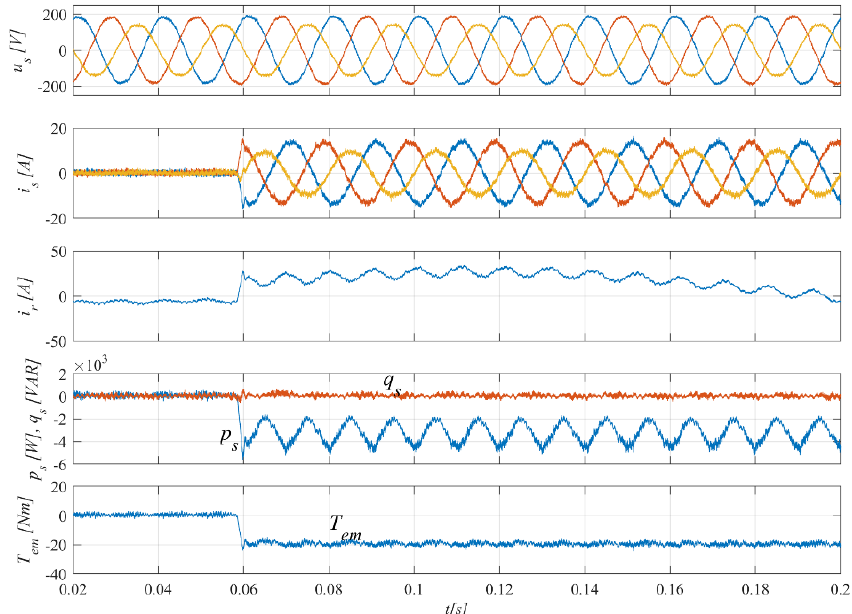
Figure 16. Experimental tests results of DPC in case of symmetrical grid voltage operation without the feedforward, decoupling mechanism and without information about the rotor current value included in the control. Q sref = 0, T emref = − 19.5 Nm.